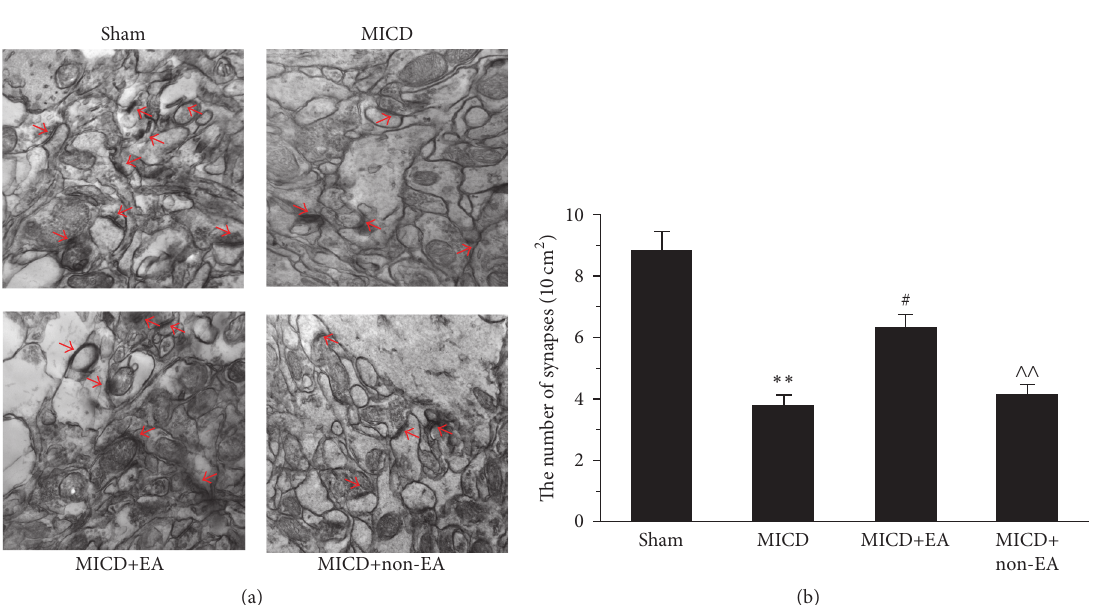
Figure 5: The number of synapses in hippocampal CA1 pyramidal cells. (a) Representative electron micrographic images of synapses (arrows) in the CA1 region of each group (magnification, × 50000). (b) Histogram shows the significant difference in the mean ± SEM of the number of synapses in each group ( 𝑛 = 5 /group; ∗∗ 𝑝 < 0.01 versus the Sham group; ## 𝑝 < 0.01 , # 𝑝 < 0.05 versus the MICD group; ∧∧ 𝑝 < 0.01 , ∧ 𝑝 < 0.05 versus the MICD+EA group).